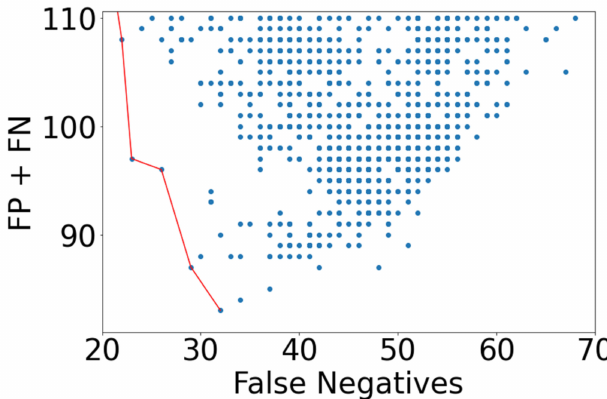
Figure 5. NN modeling results indicating the models with lowest FP + FN and FN counts. The red line indicates a Pareto front.